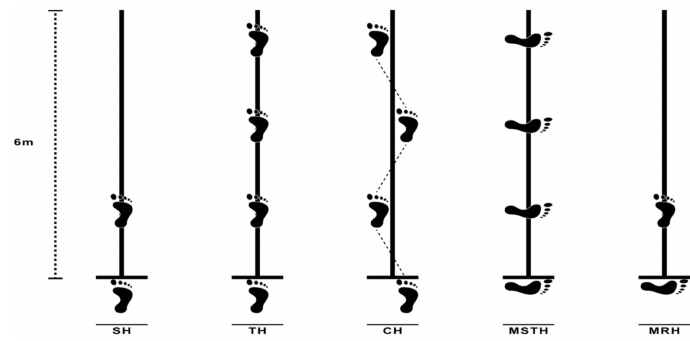
Figure 1. Graphical illustration of the single-leg hop tests.